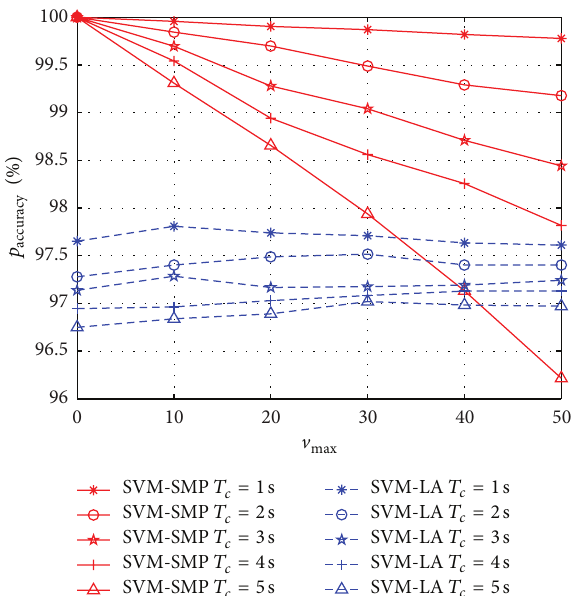
for CUs versus 𝜆 . accuracy